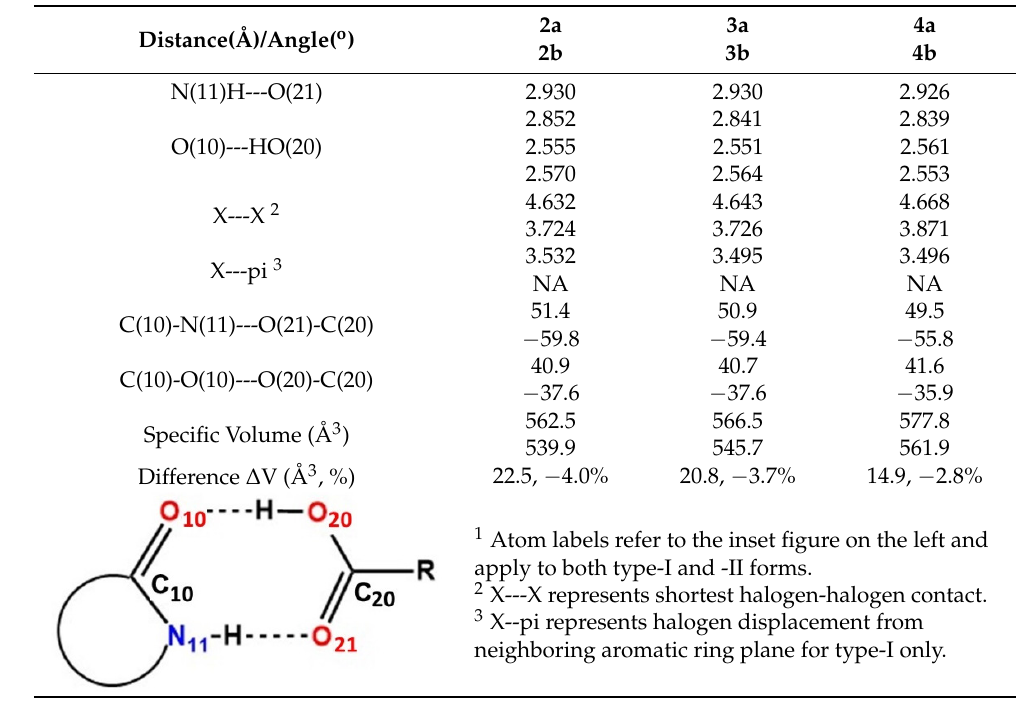
Table 3. Supramolecular geometric comparison for Type I ( a ) and II ( b ) polymorphs 1 .